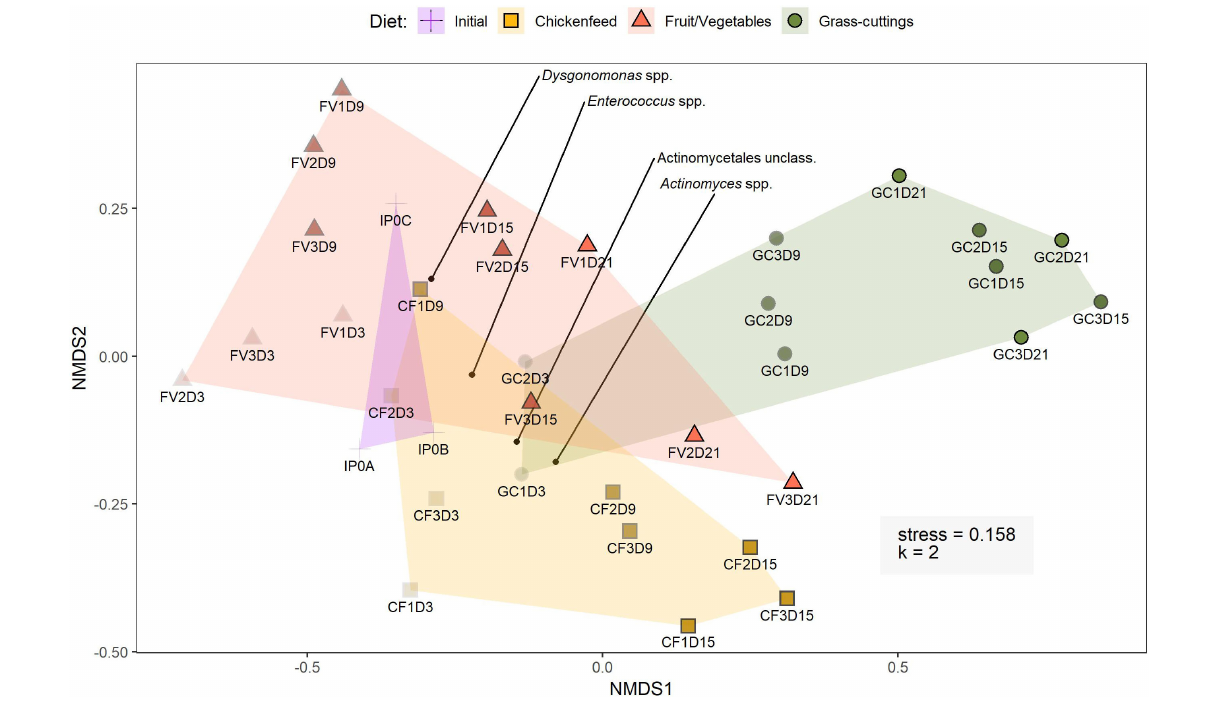
FIGURE 6 | Bray–Curtis based non-metric multidimensional scaling of operational taxonomic units (OTUs) present in at least five samples. OTUs were clustered based on 97% similarity. The gradual increase in shading of data points indicates the progression from early to late sampling time-points (light = early, dark = late). Initial samples represent the initial larval gut microbiome composition at t 0 before the introduction of new diets. The four black points indicate the distribution of core OTUs present in at least 80% of the samples. Sample labels consist of diet (IP = initial population, CF = chickenfeed, FV = fruit/vegetable mix, GC = grass-cuttings), the day of sample collection (0–21), and the replicate (1–3) (e.g., CF1D3 = chickenfeed fed larvae, first replicate collected at t 3